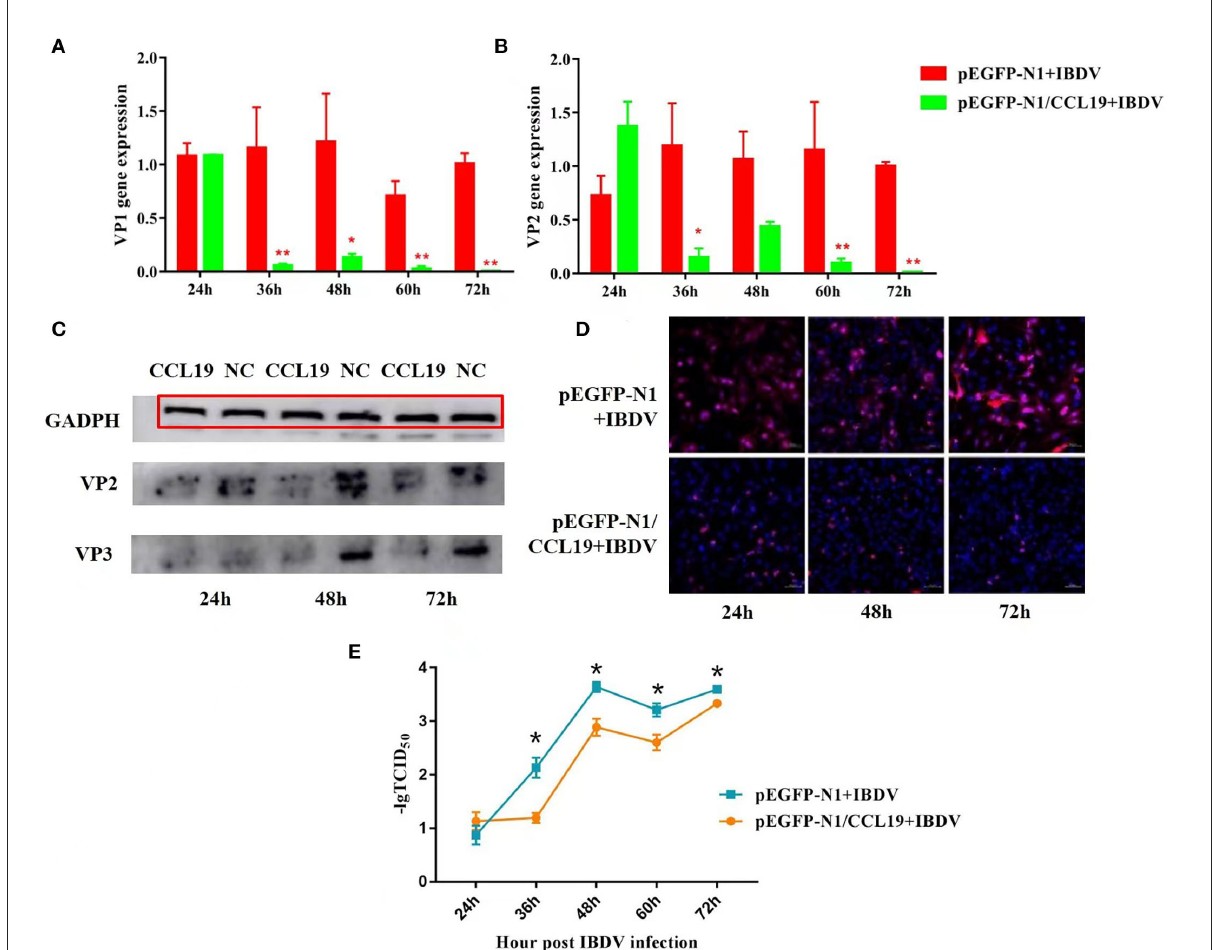
FIGURE3 Negative regulation of overexpression CCL19 on IBDV replication at different time points in DF1 cells. Gene expression levels of VP1 (A) and VP2 (B) at 24, 36, 48, 60, and 72h post-infection with IBDV B87 strain in pEGFP-N1/CCL19 group compared with empty vector plasmid pEGFP-N1 control group. (C) VP2 and VP3 protein expression levels of the empty vector plasmid pEGFP-N1 negative control group (NC) and pEGFP-N1/CCL19 group (CCL19) at 24, 48, and 72h post-infection with IBDV. (D) Semi-quantification of IBDV by indirect immunofluorescent method of pEGFP-N1/CCL19 group compared with empty vector plasmid pEGFP-N1 negative control group at 24, 48, and 72h post-infection with IBDV. Notably, 1.0 µ g empty vector or pEGFP-N1/CCL19 plasmid was used in virus infection experiment. (E) TCID 50 at 24, 36, 48, 60, and 72h post-infection with IBDV B87 strain in pEGFP-N1/CCL19 group compared with empty vector plasmid pEGFP-N1 control group. * or ** indicates that there were significant differences of VP1, VP2 gene expression levels or TCID 50 between pEGFP-N1 and pEGFP-N1/CCL19 groups ( p < 0.05 or p < 0.01). The red box indicates the GAPDH band.